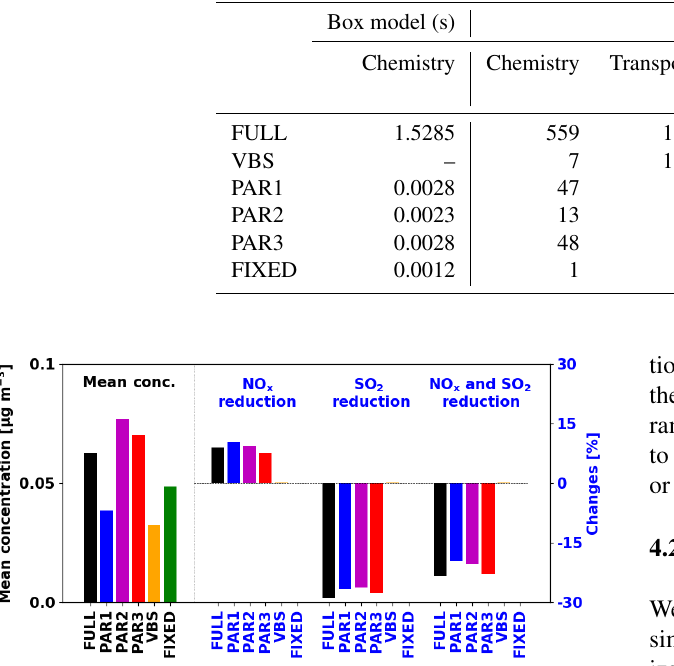
Table 1. Computational time estimation for the simulation of IEPOX-SOA using the full chemistry and parameterization cases in the box model and GEOS-Chem. The box model results are mean values of 1000 simulations based on 5d integration time. The VBS was not simulated in the box model, because the VBS requires the partitioning calculation with preexisting aerosol concentrations, which are not available in the box model and are calculated online in GEOS-Chem. For GEOS-Chem, values were based on 7d simulation using 32 cores on the NCAR Cheyenne machine. The Gprof performance analysis tool was used to calculate how much time was spent in subroutines with Intel Fortran Compiler 17.0.1 with the “-p” option. For GEOS-Chem, values were estimated by multiplying the total time spent in each process by the contribution of related reactions/species for each case, except for time estimates for chemistry of PAR1–3 and FIXED. For example, transport time in full chemistry was calculated by multiplying 2978s (total transport time in Table S4) by 10 (total number of the explicit full chemistry species relevant to IEPOX-SOA formation)/173 (total number of advected species).